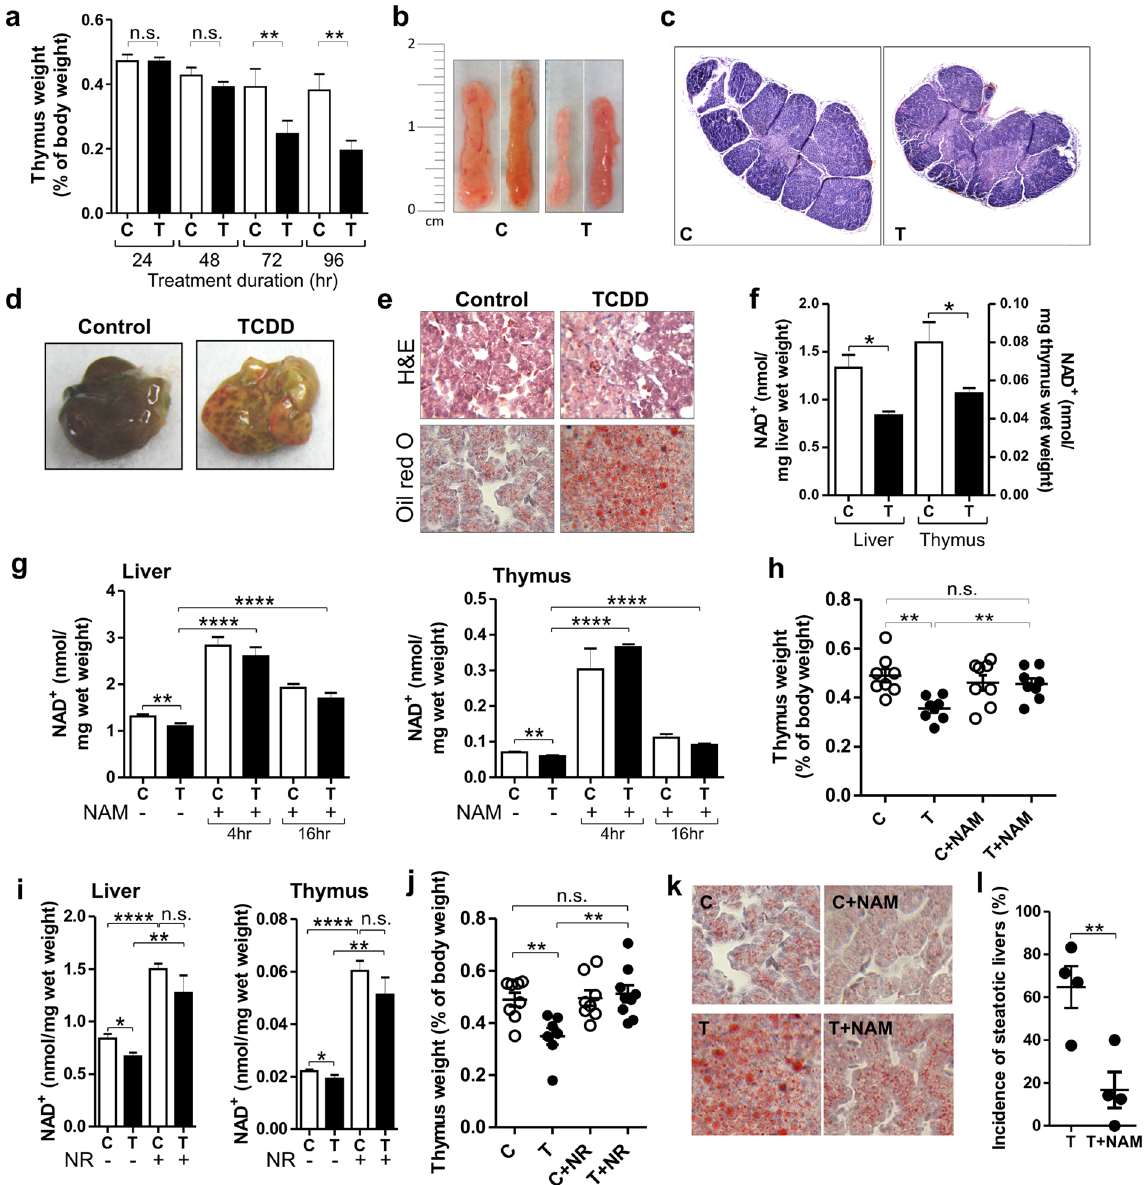
Figure 1. TCDD produces toxic effects while decreasing NAD + levels. Prevention by NAD + repletion. ( a ) Mean thymus weights as percentages of body weight ± SE for CE treated with TCDD (T) or dioxane (vehicle control, C). For 24 and 48 hr time points, n = 8 individual embryos. For the 72 and 96 hr time points, 4 independent experiments with n = 3–8 embryos per treatment group. ( b ) Photographs of representative CE thymus glands. ( c ) Representative CE thymus sections stained with H&E. ( d ) Representative livers from CE treated with TCDD or vehicle. ( e ) H&E and Oil Red O stained liver sections. ( f ) NAD + levels in livers and thymus glands. ( g ) Mean NAD + levels ± SE in livers and thymus glands of CE treated for 24 hr with TCDD with or without NAM during the last 4 or 16 hr of TCDD treatment (n = 3–8 CE per treatment group). ( h ) Scatter plot showing thymus weights as percentages of body weight for CE treated with TCDD or vehicle with and without NAM (n = 7–8 CE per treatment group) with means ± SE for each treatment group. ( i ) Mean NAD + levels ± SE for livers and thymus glands from CE treated with TCDD (24 hr) with or without nicotinamide riboside (NR) for the last 4 hr. ( j ) Scatter plot showing means ± SE for thymus weight for CE treated with TCDD with or without nicotinamide riboside (NR) (n = 7–9 CE per treatment group). ( k ) Representative Oil red O stained sections of CE livers. ( l ) Scatter plot for 4 independent experiments, each with n = 7–10 CE per treatment group, showing the incidence of steatosis. Control livers lacked signs of steatosis. For all Figures: * p < 0.05; ** p < 0.01; *** p < 0.001; **** p < 0.0001; n.s., not significant; TCDD treatment was for 72 hr unless